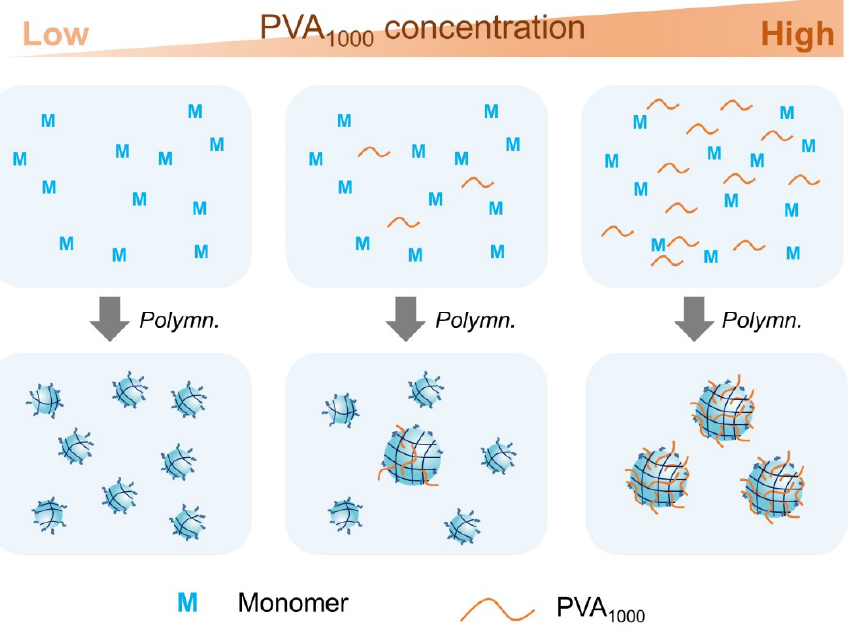
Scheme 3. Schematic of the effect of the PVA 1000 concentration on nanogel formation.